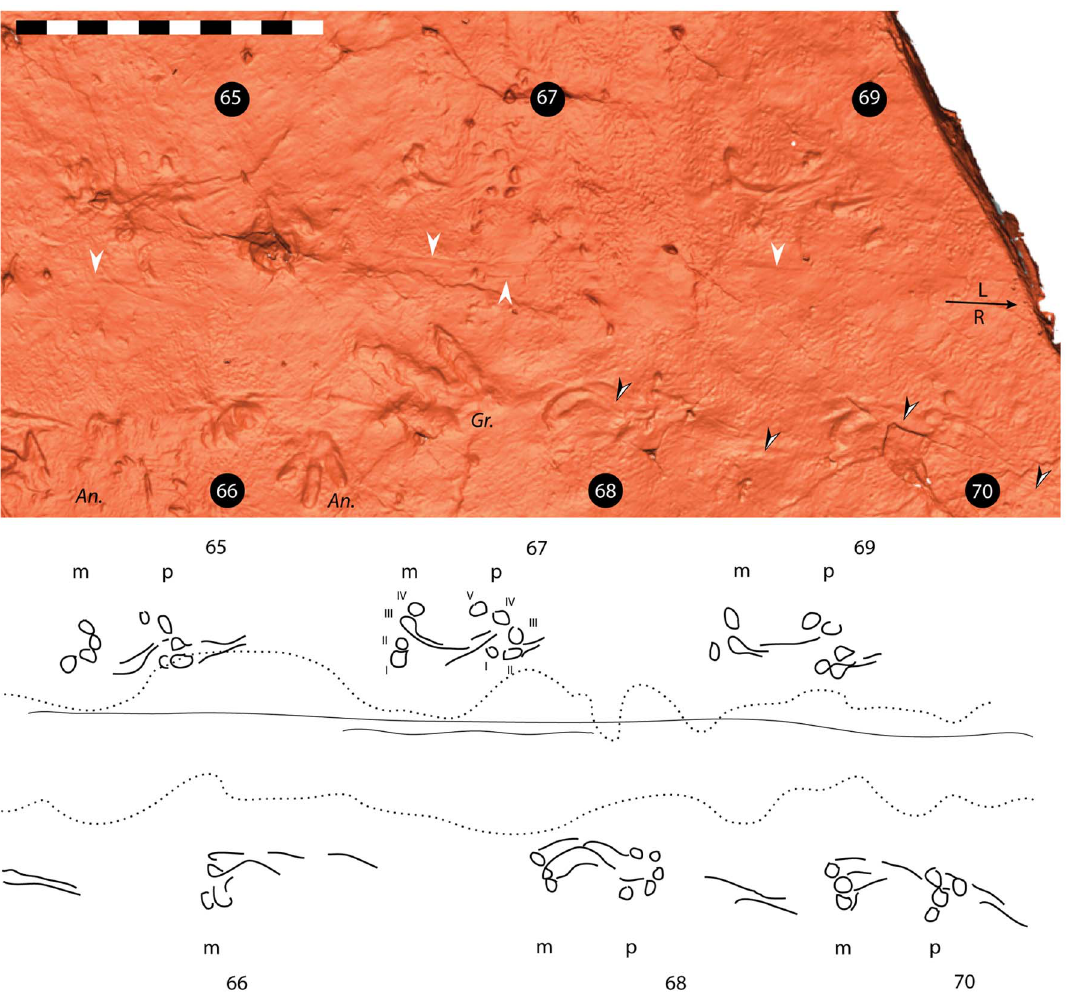
Figure 4. Episcopopusventrosus . Scanned image (top) and interpretive line drawing (bottom) of manus-pes pairs 65–70. Odd numbers represent left manus-pes pairs; even numbers indicate right manus-pes pairs. Direction of travel and left ( L ) and right ( R ) are indicated by the arrow at right. Abbreviations: I – V , digits; An . , Anamoepus ; Gr . , Grallator ; m , manus; p , pes. White arrowheads indicate straight drag marks probably made by the base of the tail; black and white arrowheads indicate manual digit drag marks. Scale equals 1 m.